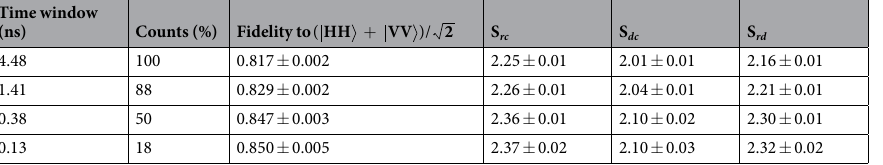
Table 2. Calculated fidelity to + ( HH VV )/ 2 for four different time windows. The percentage of the correlation events taken into account for a certain time window is given in the second column. The calculated Bell parameters for all three bases combinations are always above the classical limit of